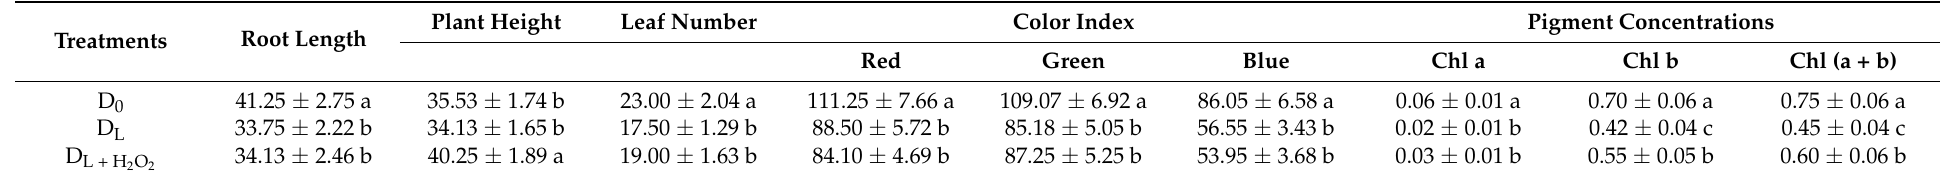
Table 3. Effects of fertigation treatments (D 0 —standard nutrient solution or control treatment, D L —raw leachate treatment and D L + H length and plant height (expressed in cm), leaf number, color index (RGB) and pigment concentrations (expressed in mg g − 1 FW) in D. deremensis plants at the end of the experimental period. The experiment simulates a cascade cropping system with different leachate treatments of Chrysalidocarpus lutescens as primary or “donor” and Dracaena deremensis as a secondary or “acceptor” plant culture. The results are expressed as means ± standard deviation ( n = 4). In each column, same letters indicate non-significant differences ( p < 0.05).